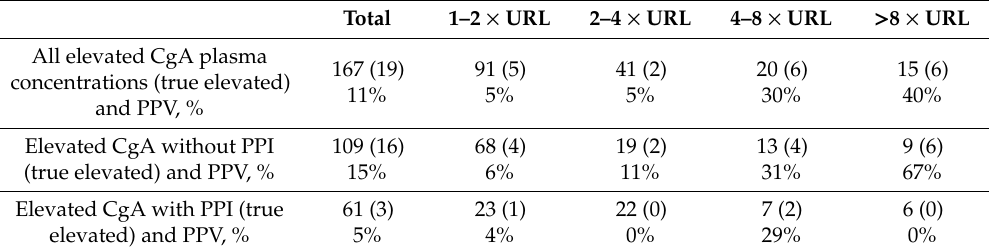
Table 4. Positive predictive value of CgA depending on PPI status and level of CgA